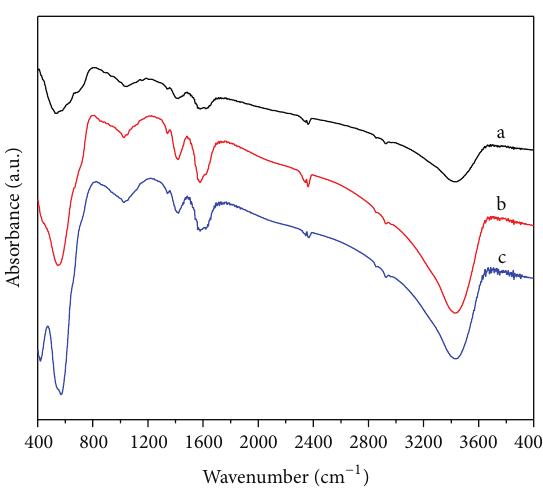
Figure 2: FT-IR spectra of (a) 4S, (b) 6S, and (c) 8S.